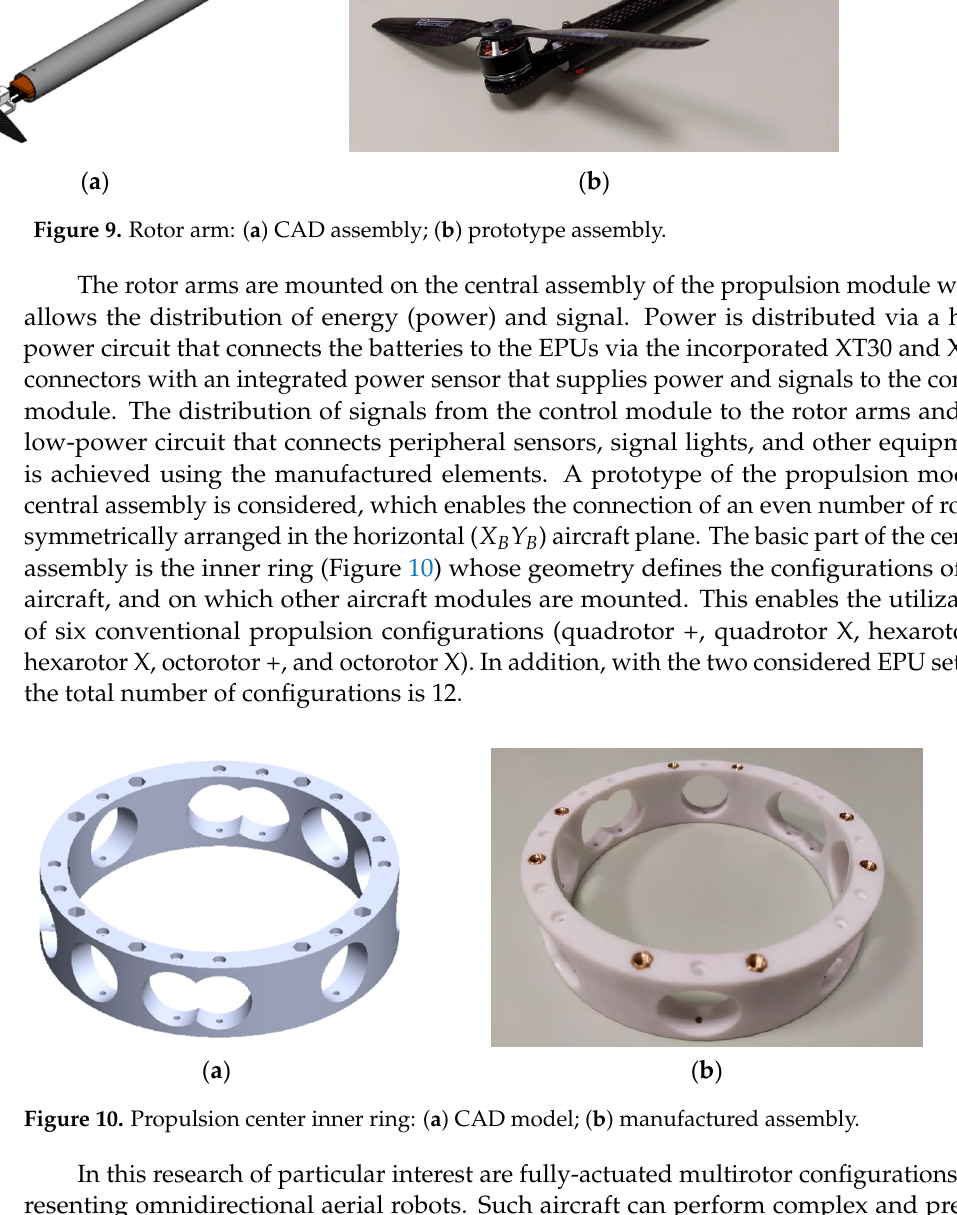
( b ) Figure 11. Propulsion module outer ring: ( a ) Part model of the propulsion assembly for fully-actu- ated configuration with six rotors; ( b ) Assembly model of the propulsion subsystem for fully-actu- ated configuration with eight rotors. 4.2. EMMR Assembly The EMMR aircraft assembly consists of the presented propulsion module, the con- trol module (avionics), the energy module, and the equipment module. In the case of an aircraft intended for experimental testing, the equipment module actually represents the landing gear. In a special case for testing the aircraft attitude, it is developed gimbal joint assembly. The control module is based on an open-source PX4 (Dronecode Foundation, San Francisco, CA, USA) flight controller (FC). For the two types of PX4 FC, discussed in the next section, parts of the control module housing have been developed. Peripheral com- ponents of the FC and remote control elements are incorporated inside the housing. The control module is connected to the top of the propulsion module as shown in Figure 12a. The energy module, which in this case consists of two LiPo batteries, is connected to the propulsion module from the bottom. Figure 12b shows a proposed 3D model of a conven- tional eight-rotor configuration, the so-called flat octorotor (FX8). Flat-layout configura-